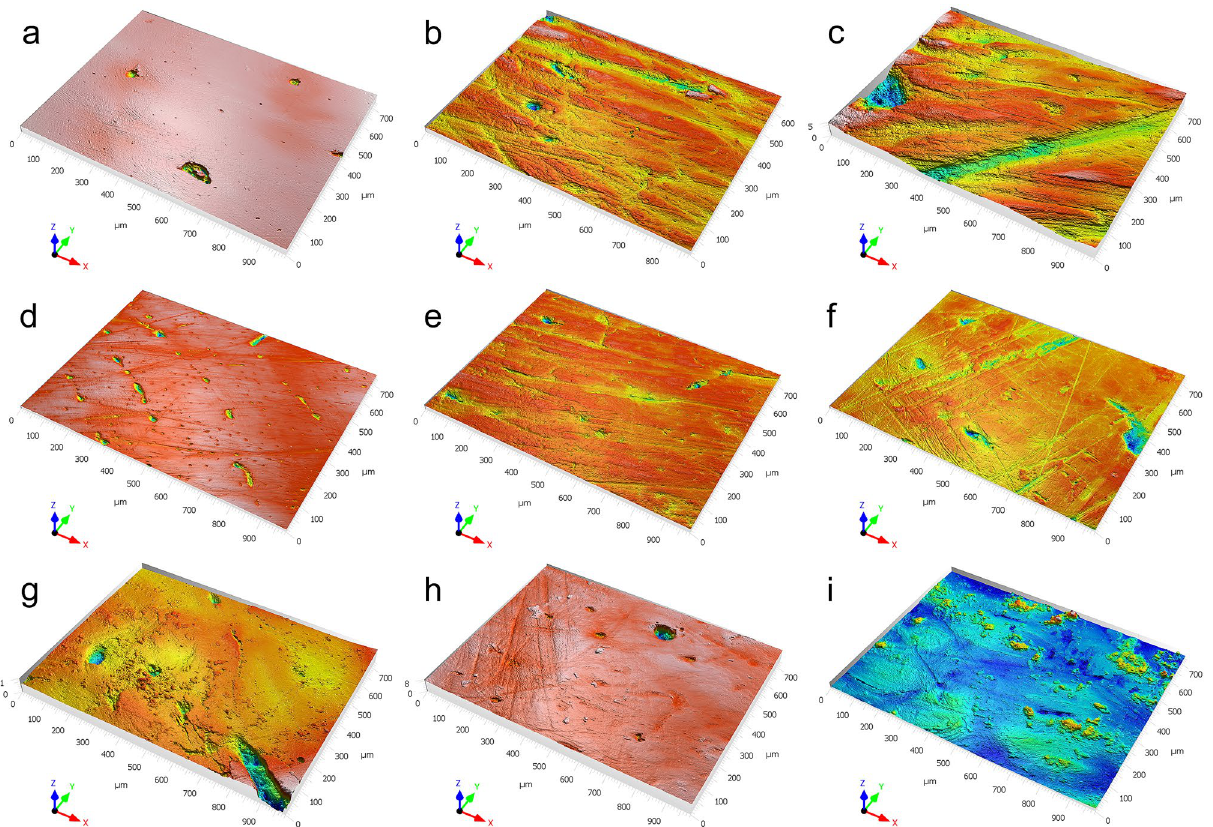
Figure 5. 3D renderings of selected areas analyzed by means of texture analysis. Comparison of 3D renderings of unused ( a ) and used ( b – i ) tools highlighting variations in wear development and intensity resulting from the use of bone tools in distinct activities, i.e., digging in dry sediment ( b ) versus humus-rich soil for 20 min ( c ), processing rabbit skin without ( d ) and with ( e ) ochre for 20 min, and debarking oak trees ( f ) over an extended period of time. Experimental ( b – e ), ethnographic ( f ), and archaeological specimens found in pre-Still Bay layers BS9 and BS14 (see Fig. 2s, w) ( g , i ), and in Howiesons Poort layer PGS3 (see Fig. 2c) ( h